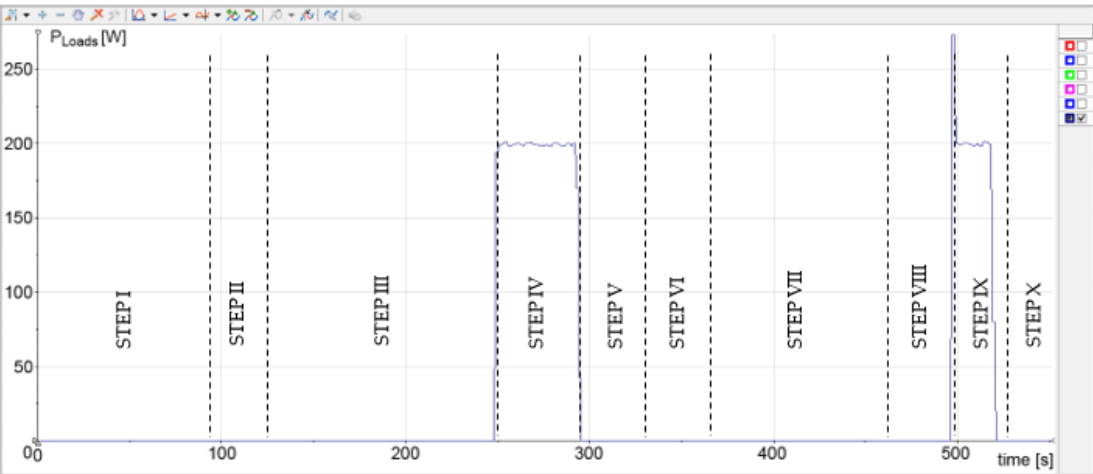
Figure 13. Total PV power production: PV power plant plus PV power simulator.